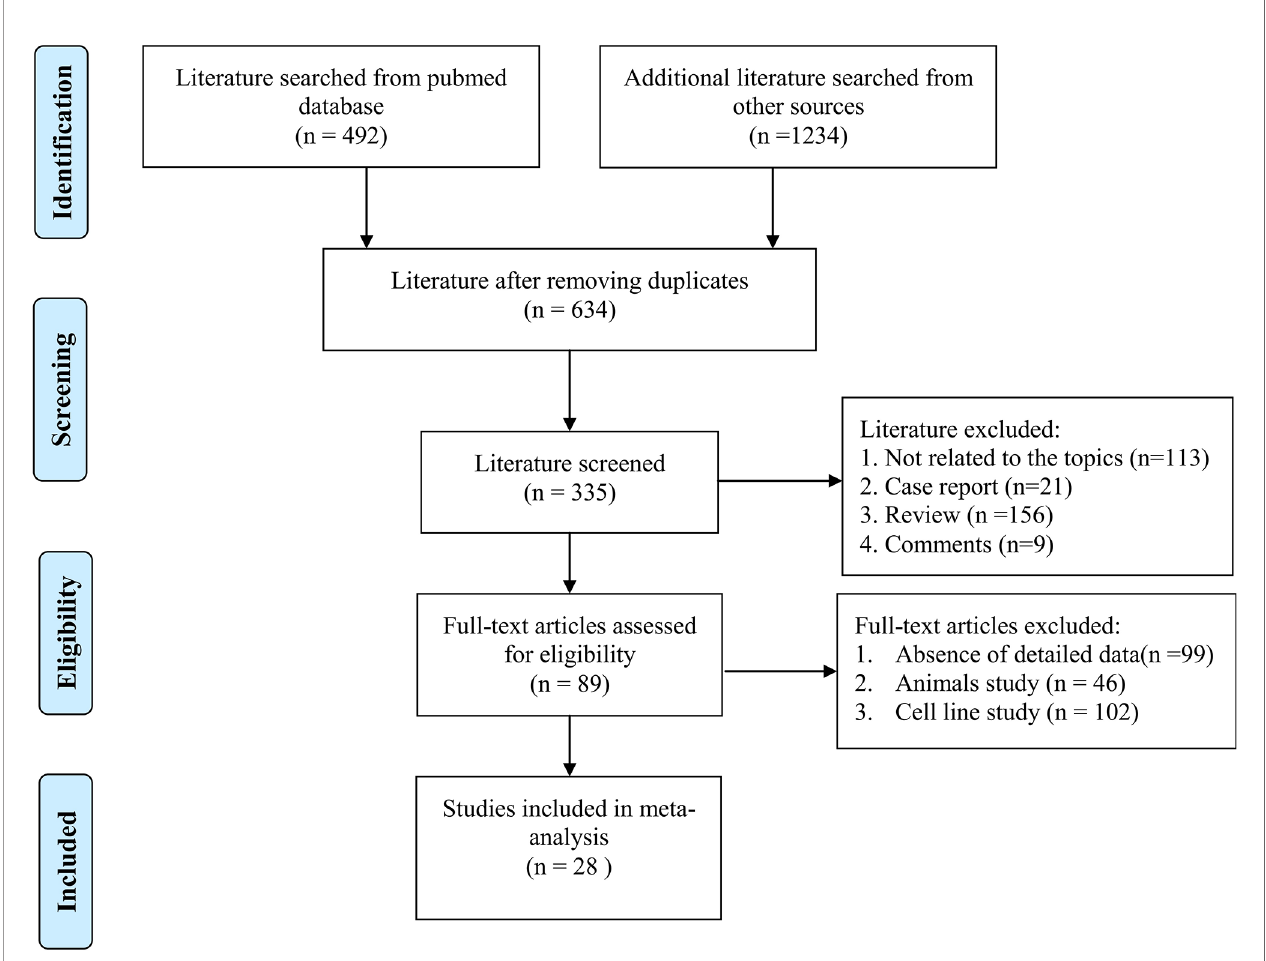
FIGURE 1 | The diagram fl owchart of studies for selecting